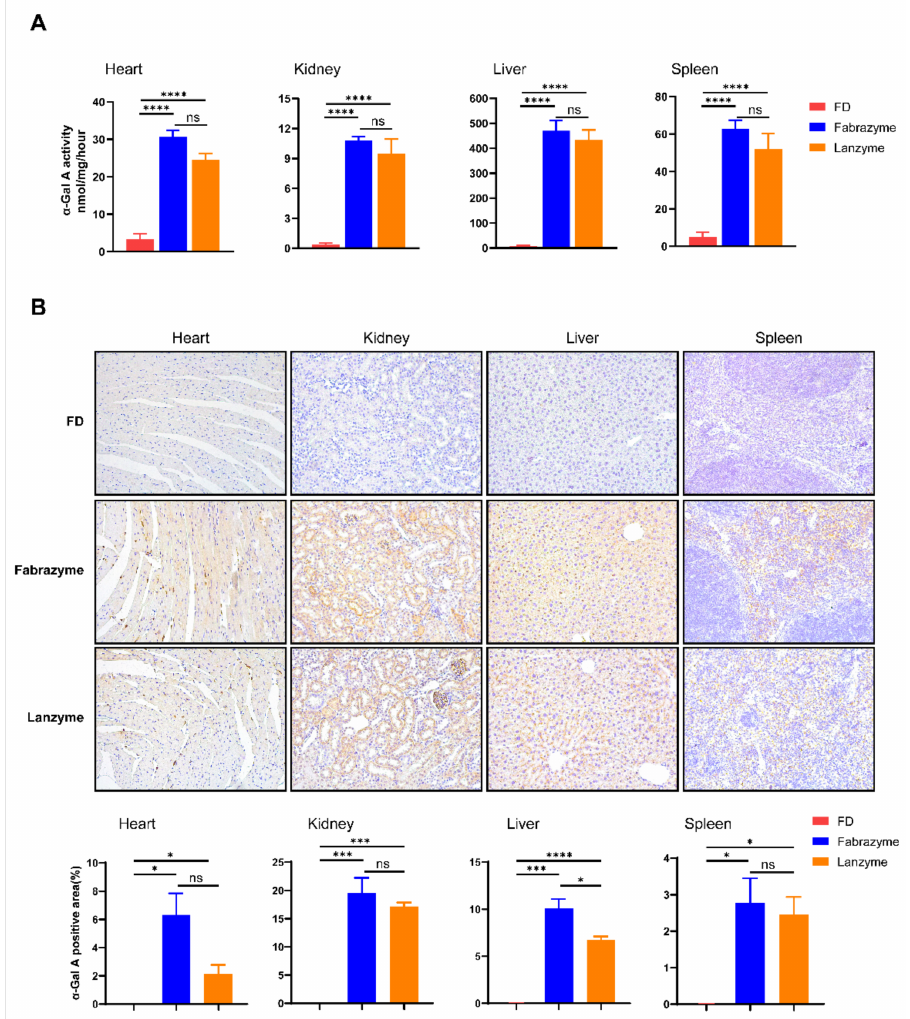
Figure 4. Lanzyme activity and tissue distribution in organs of FD mice. ( A ) Twelve-week-old male FD mice were administered an intravenous infusion of 1 mg/kg of Lanzyme. Heart, kidney, liver, and spleen were collected 7 days after infusion, and the activity of α -galactosidase A ( α -Gal A) was determined. Each bar represents the mean ± SEM of five to six mice per group. **** p < 0.0001 compared with FD; ns * p > 0.05 compared to Fabrazyme; one-way ANOVA. ( B ) Twelve-week-old male FD mice were given an intravenous bolus injection of 1mg/kg Lanzyme. Tissues were collected seven days after administration, and IHC staining was conducted on paraffin sections using an anti-human α -Gal A antibody. IHC of Lanzyme in WT mice tissue semi-quantitative analyses were conducted using Image J software. * Comparison between FD group. * p < 0.05, *** p < 0.001, **** p <